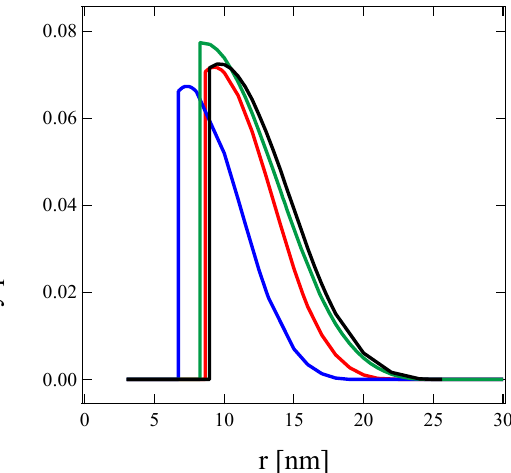
Figure 7. Radial density profile of the corona chains for 0.5 wt % C3Ms of A + S ( red ), A + C ( blue ), G + S ( black ), and G + C ( green ) (color online).